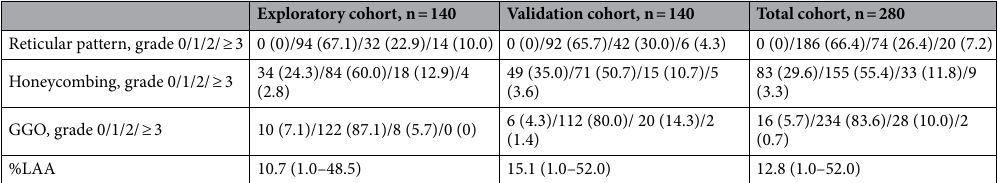
Table 2. Findings of chest computed tomography in patients with idiopathic interstitial pneumonias. Data presented as median (range) or number (%). The extent of chest CT findings were semi-quantitatively evaluated as follows: grade 0 (0%), grade 1 (< 25%), grade 2 (25–50%), grade 3 (50–75%), and grade 4 (> 75%). GGO ground-glass opacity, %LAA percentage low-attenuation area.